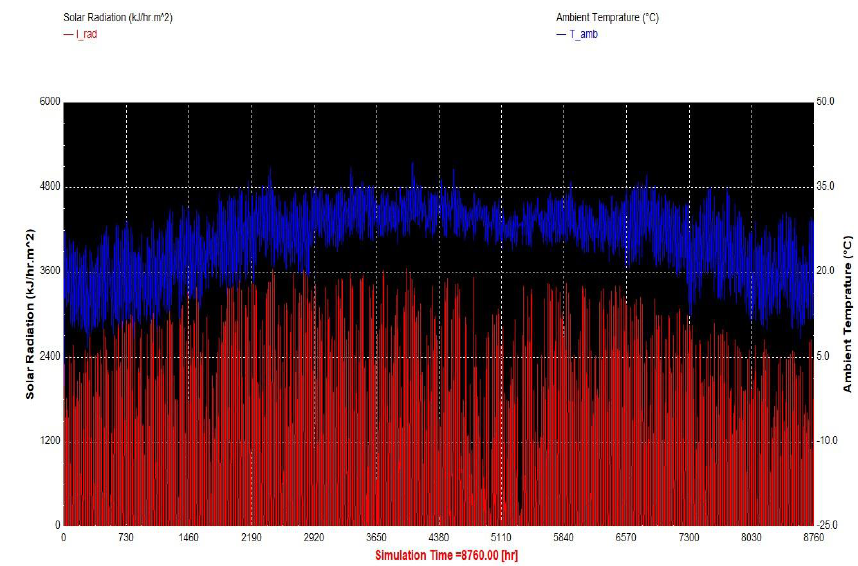
Figure 4. Jamshoro weather profile.